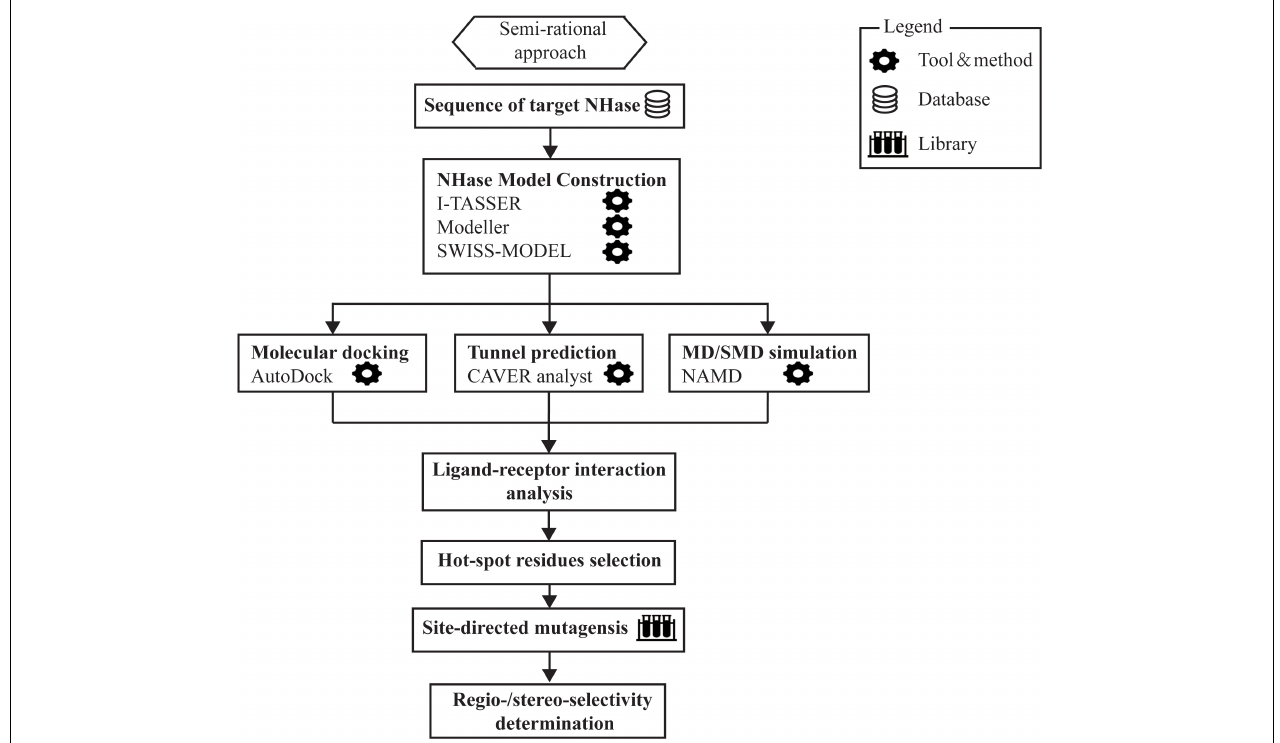
FIGURE 4 | The outlay of semi-rational approach involved in the modification of regio- and stereo-selectivity of NHase.